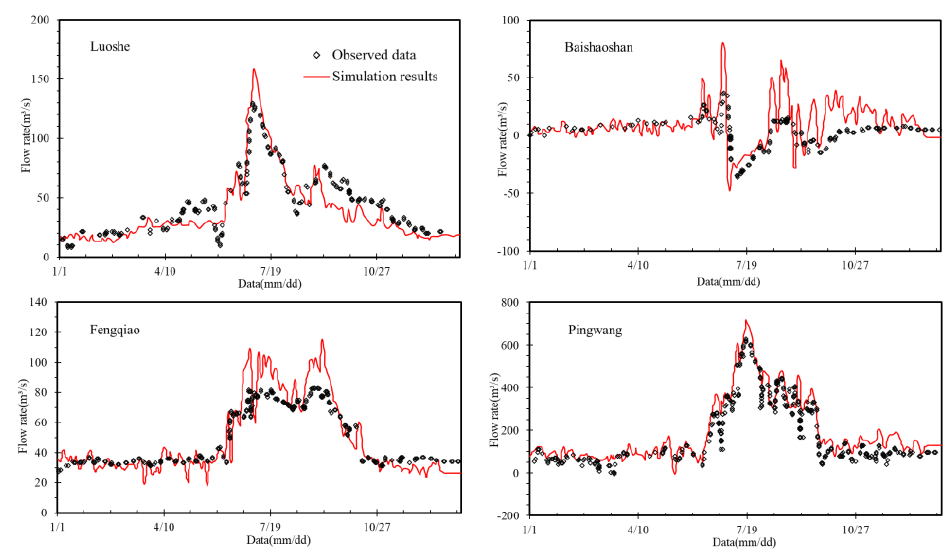
Figure 12. The comparison of simulated and observed discharge in Luoshe, Baishaoshan, Fengqiao, and Pingwang in 1999.